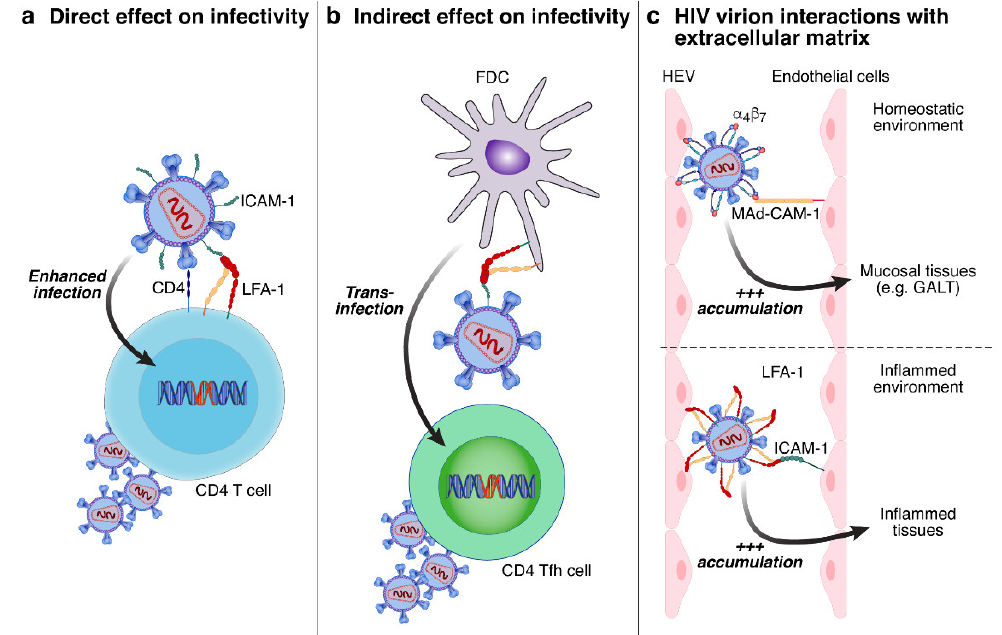
Figure 4. Host molecules incorporated into HIV virions influence virion-cell interactions. The incorporation of host molecules might influence HIV pathogenesis by promoting the interaction between HIV virions and susceptible cells. The incorporation of host molecules (e.g., ICAM-1) might promote HIV virion infectivity through: ( a ) the direct interaction with susceptible cells; and ( b ) trans-infection through the interaction with FDC. ( c ) Incorporated molecules (e.g., α4β7 and LFA-1) might promote HIV virion attachment to endothelial cells and thus enhancing the interaction with susceptible cells either in homeostatic or inflamed environments.